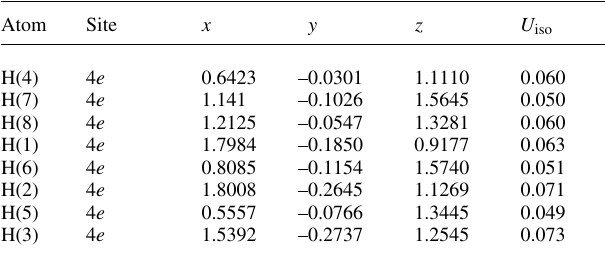
Table 2. Atomic coordinates and displacement parameters (in Å 2 ) .